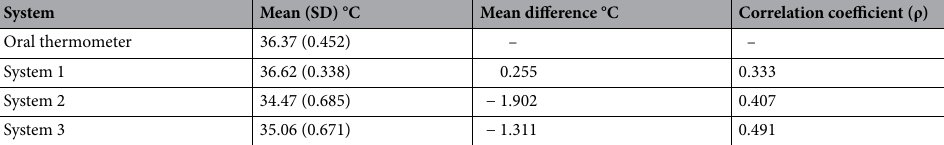
Table 3. The data from each IRT system, and the oral thermometer. The correlation coefficient is for each IRT system against the oral